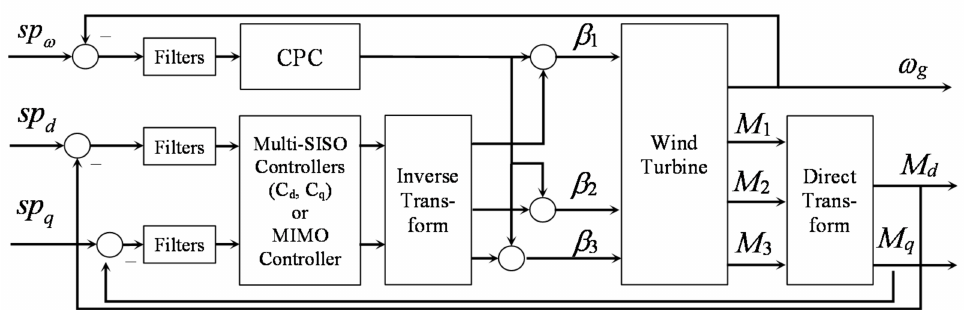
Figure 8. General configuration of an individual pitch control system with transformations.